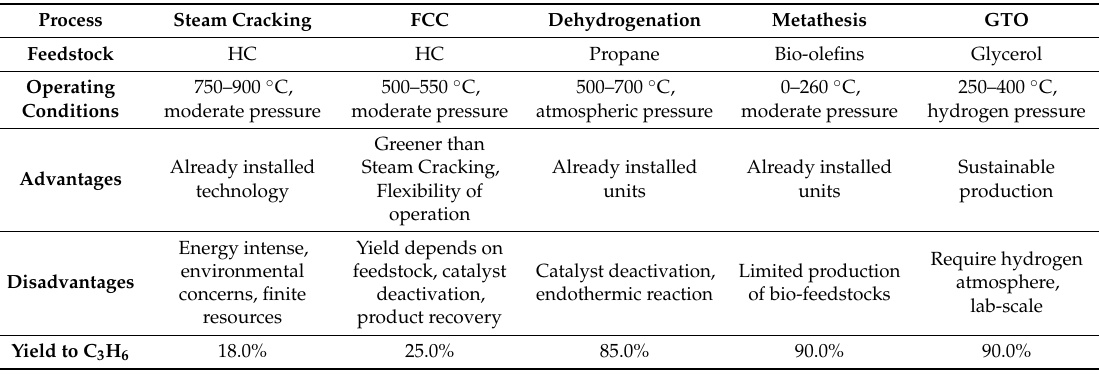
Table 4. Comparison of C 3 H 6 production processes. Table (cid:561) 4. (cid:561) Comparison (cid:561) of (cid:561) C 3 H 6 (cid:561) production (cid:561) processes. (cid:561)